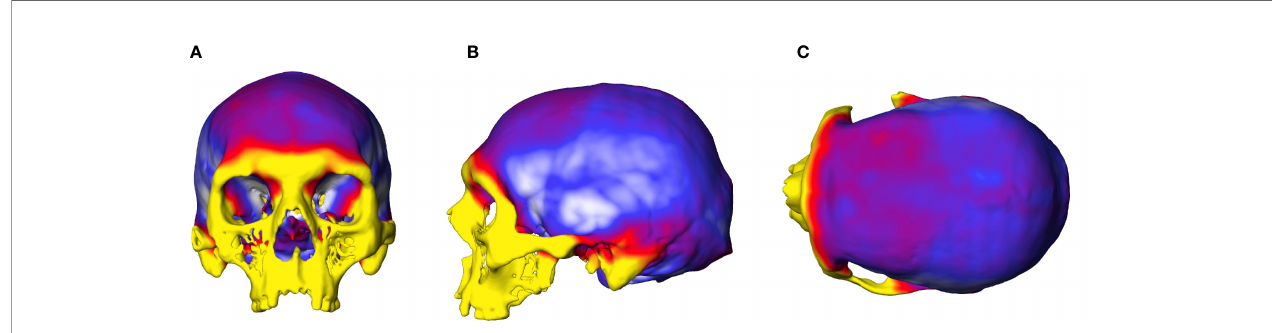
FIGURE 4 | Graphic representation of the cranial thickness of the female with gigantism and acromegaly. (A) anterior view of the cranium, (B) lateral view of the cranium, (C) superior view of the cranium. Colours indicate the variation in bone thickness, from white (2mm) to dark red/yellow (22